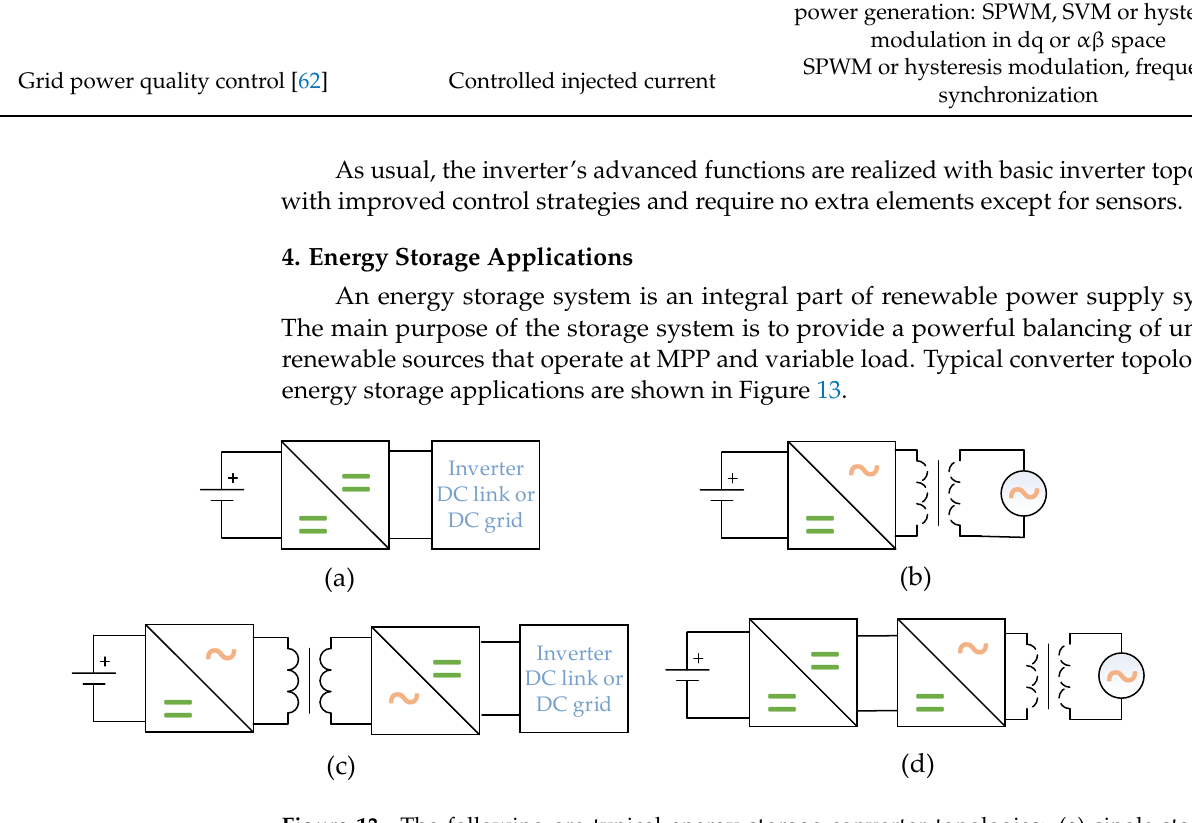
Figure 13. The following are typical energy storage converter topologies: ( a ) single-stage DC – DC application; ( b ) single-stage DC – AC application; ( c ) two-stage isolated DC – DC application; ( d ) two- stage DC – AC application.